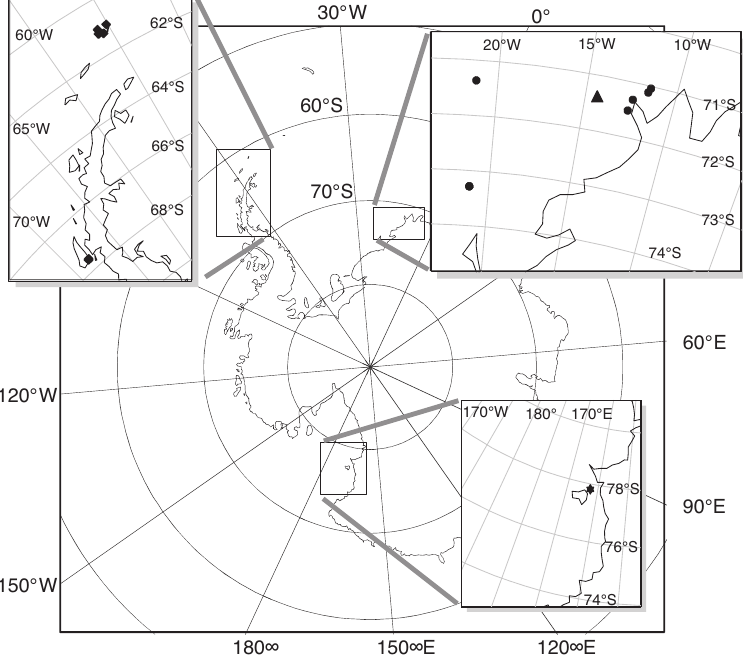
Fig. 1. – The sampling locations of nominate Glyptonotus antarcticus in the Southern Ocean The four mitochondrial haplotypes, possibly representing four species, are: Antarctic Peninsula ( (cid:1) ), Eastern Weddell Sea group A ( (cid:2) ), Eastern Weddell Sea group B ( (cid:3) ), Ross Sea ( (cid:4) 176 C. HELD and J.-W. WÄGELE